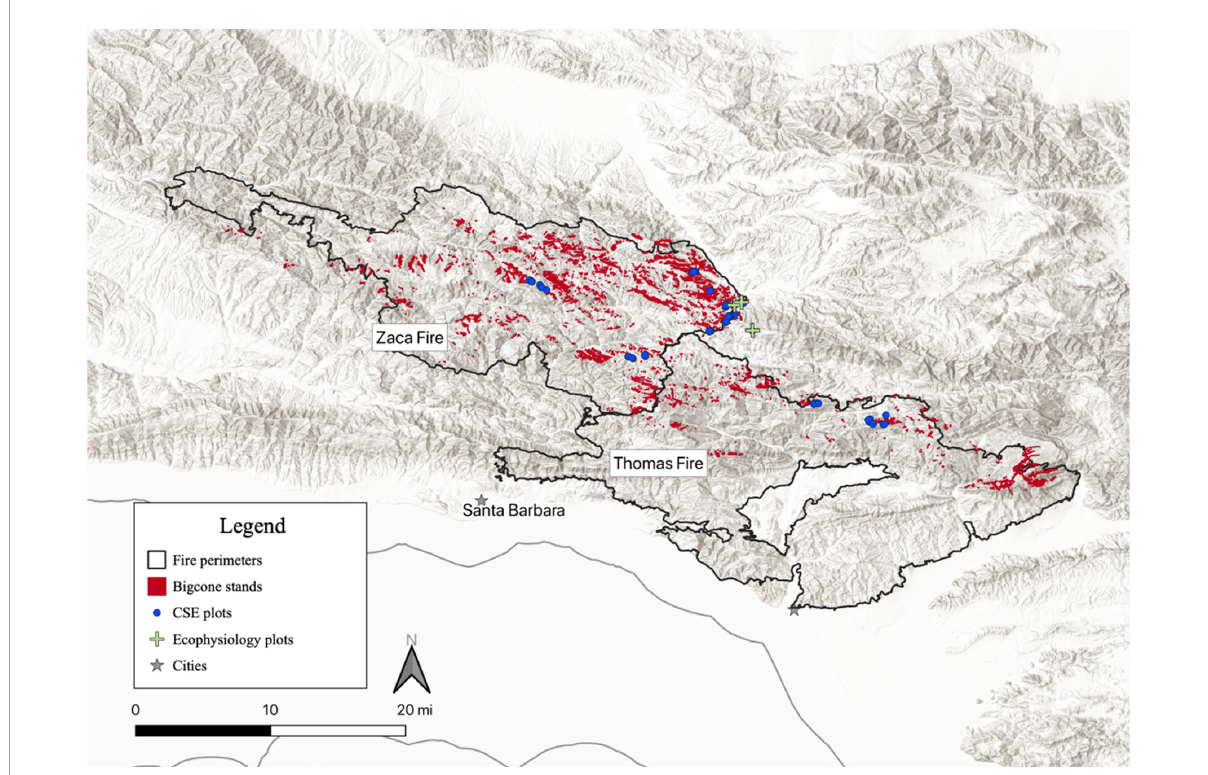
FIGURE2 Map of study region along the southern California coast. Black outlines demarcate fire scar perimeters (from National Interagency Fire Center) for Zaca (2007) and Thomas (2017) fire areas; red polygons correspond to bigcone Douglas-fir stands identified using Google Earth imagery (see Supplementary Figure 2 ) and used for delineation of bigcone stands for remote sensing analyses. Blue dots show plots where common stand exams (CSE) were conducted and green crosses show the four sites used for ecophysiological measurements.